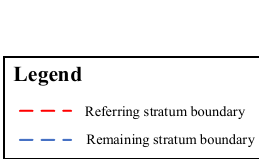
Figure 4. Diagrammatic sketch of stratum